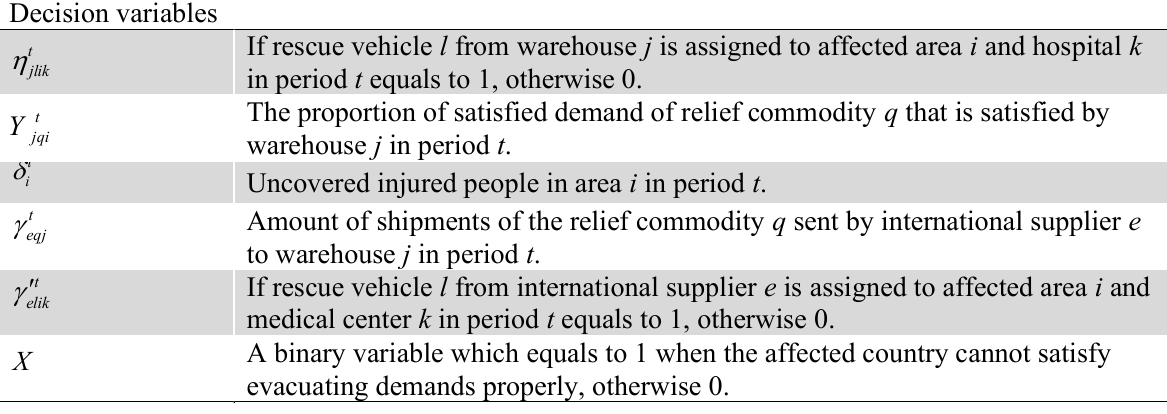
Definition of decision variables Decision